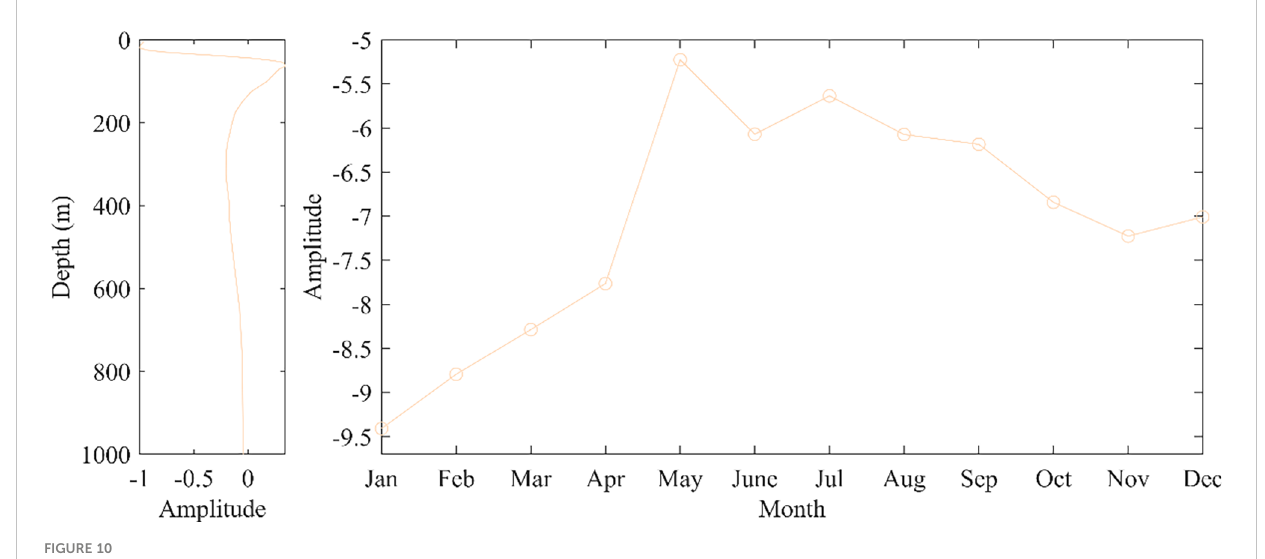
FIGURE 10 Time and space functions of Type